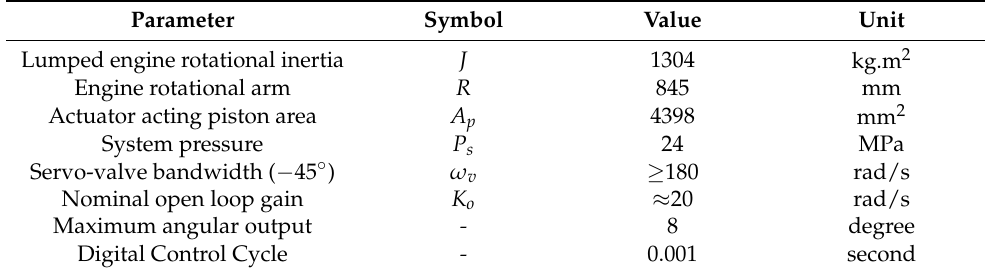
Table 1. The main parameters of an actuation system.